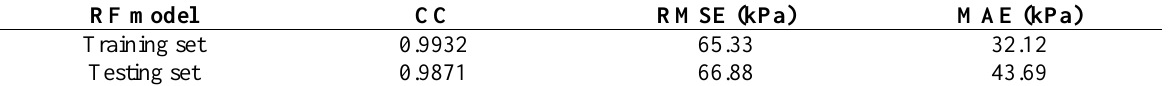
Table 3. Results of the optimum model with respect to training and testing sets RF